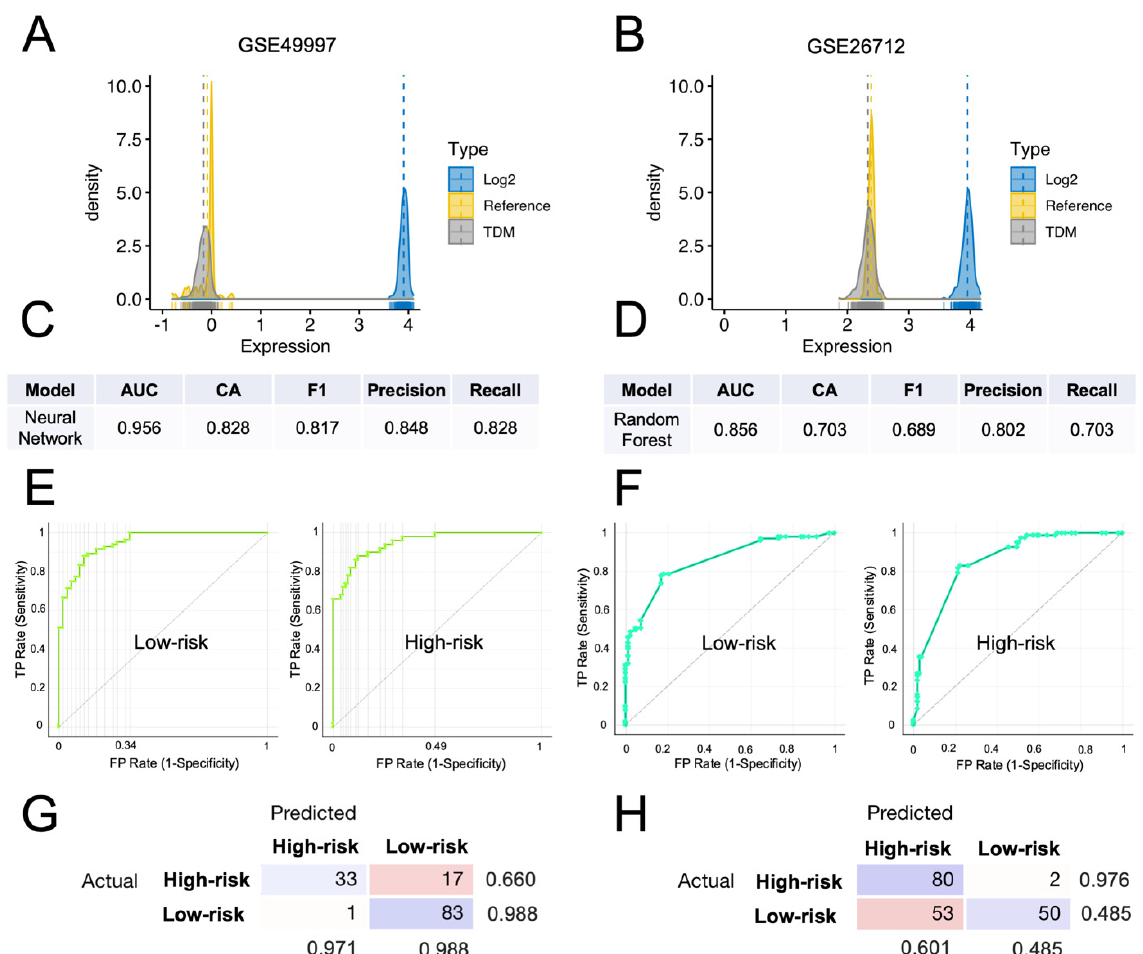
Figure 6. External validation of the computational classification of the HGSOC-TMI risk group. ( A , B ) Density plots of the TDM and log 2 -transformed training data (TCGA) against the validation datasets (GSE49997 and GSE26712). ( C ) Results of the neural-network model, which had the best score in the classification of the risk groups in the GSE49997 dataset. ( D ) Results of the random- forest model, that had the best score in the classification of the risk groups in the GSE26712 dataset. ( E ) Receiver operating characteristic (ROC) curves for two HGSOC-TMI risk groups for the GSE49997 and ( F ) GSE26712 datasets. ( G , H ) Confusion matrixes showing the number of patients correctly classified by using the best predictive model for each dataset.